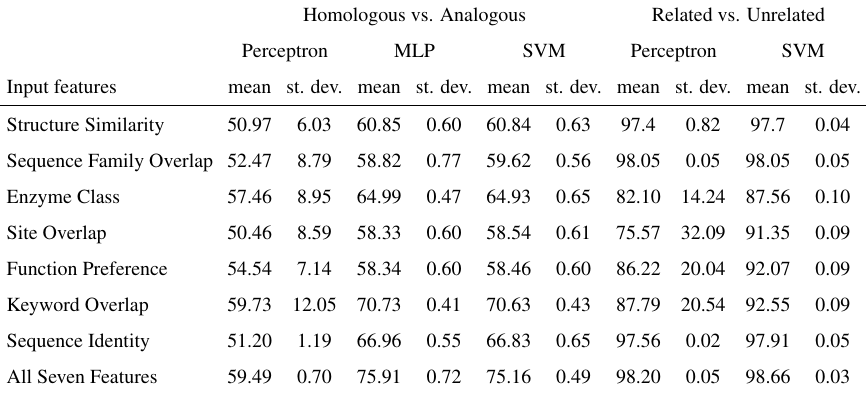
Table 1: Recognition rates (percentage) obtained for di ff erent classifiers on the two problems.